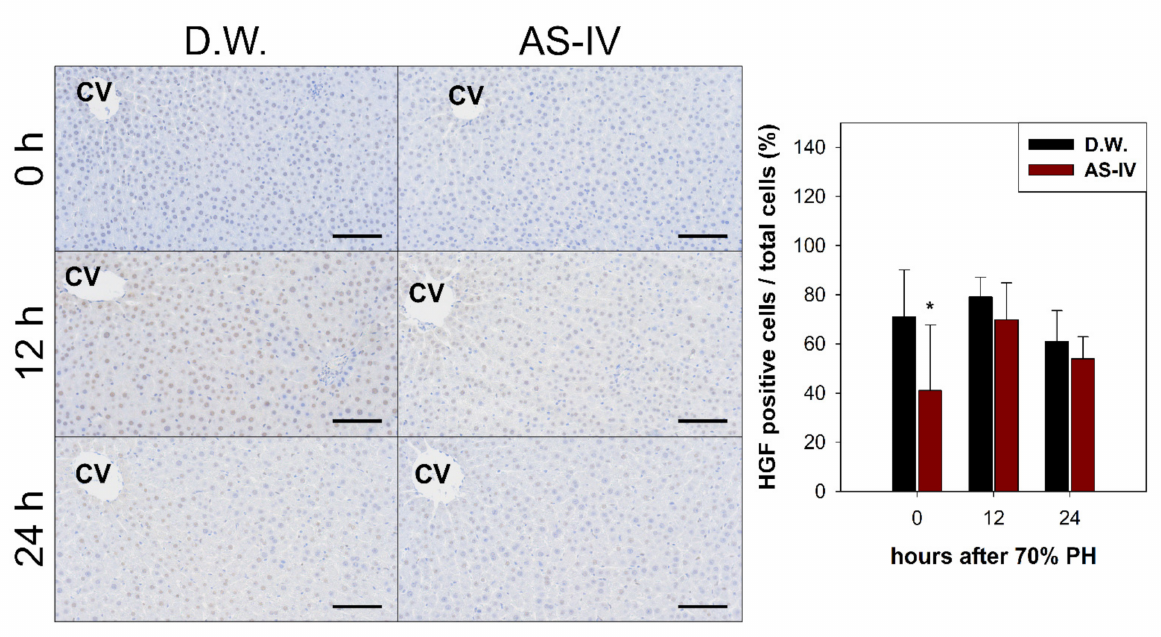
Figure 4. Immunostaining for HGF. HGF-immuno-positive reactions were a brown color after immunostaining. HGF peaked at 12 h after PHx. The AS-IV group showed a low expression of HGF. Hematoxylin was used as a counter stain. (Scale bar indicates 100 µ m, CV: central vein, n = 3, mean ± standard deviation, *: p < 0.05).